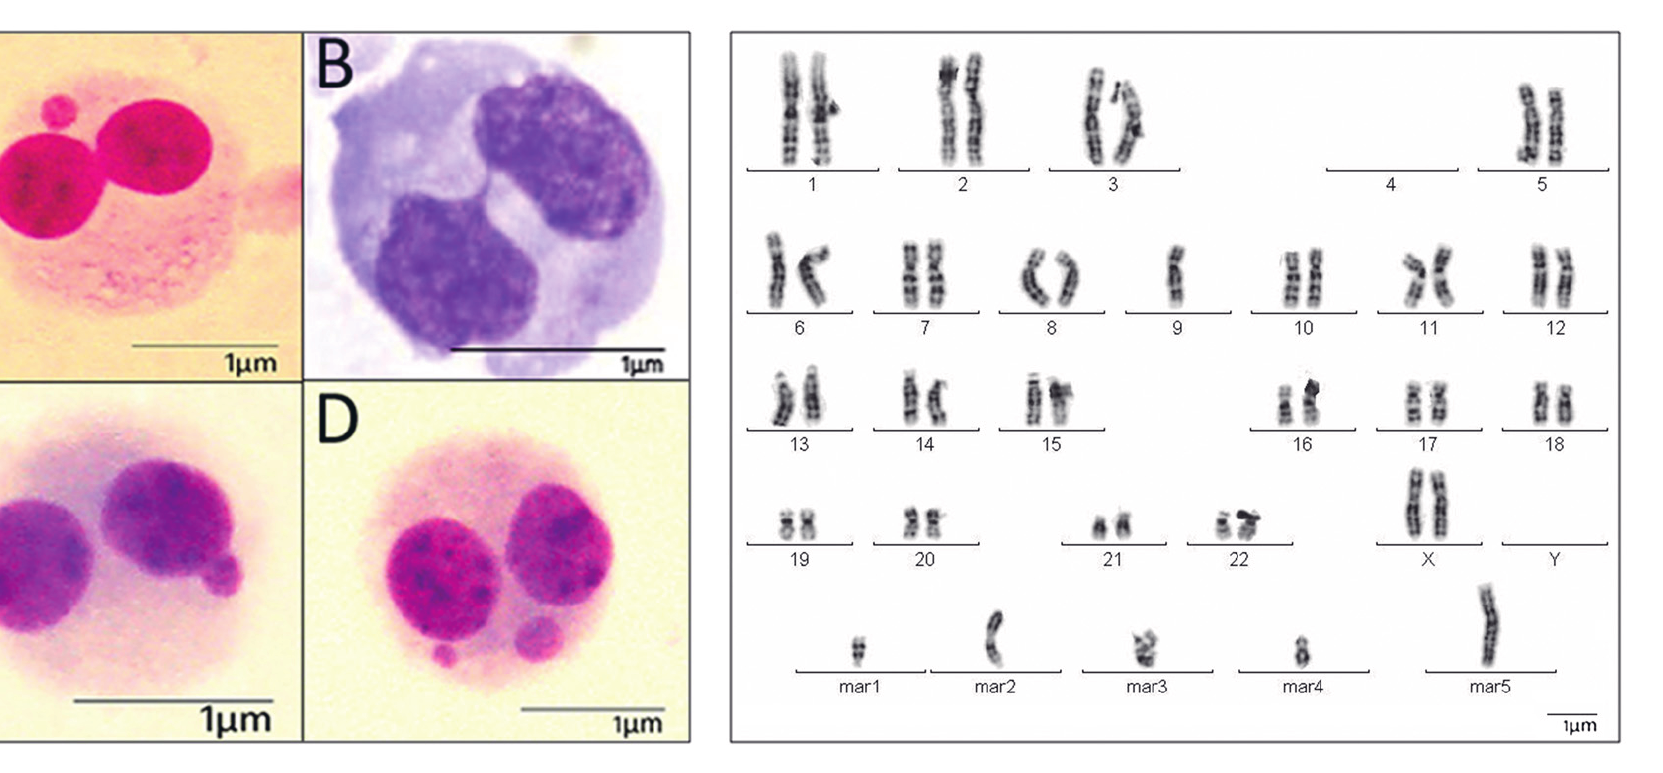
Figure 2. Genotoxic study using nuclear abnormalities and chromosome damage as biomarkers. Binuclear cells (left) showing: ( A ) one micronucleus, ( B ) nucleoplasmatic bridges, ( C ) nuclear buds, ( D ) two micronuclei; and Karyotype (right) with five marker